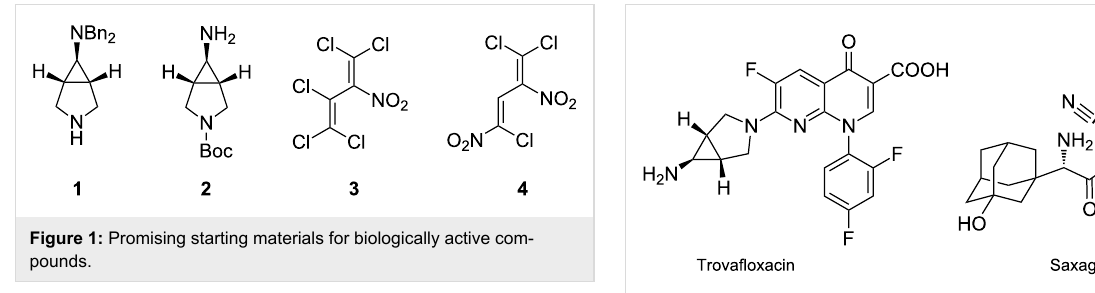
yield (Scheme 1). The interest in such compounds derives from the fact that a number of similar hydrazones,